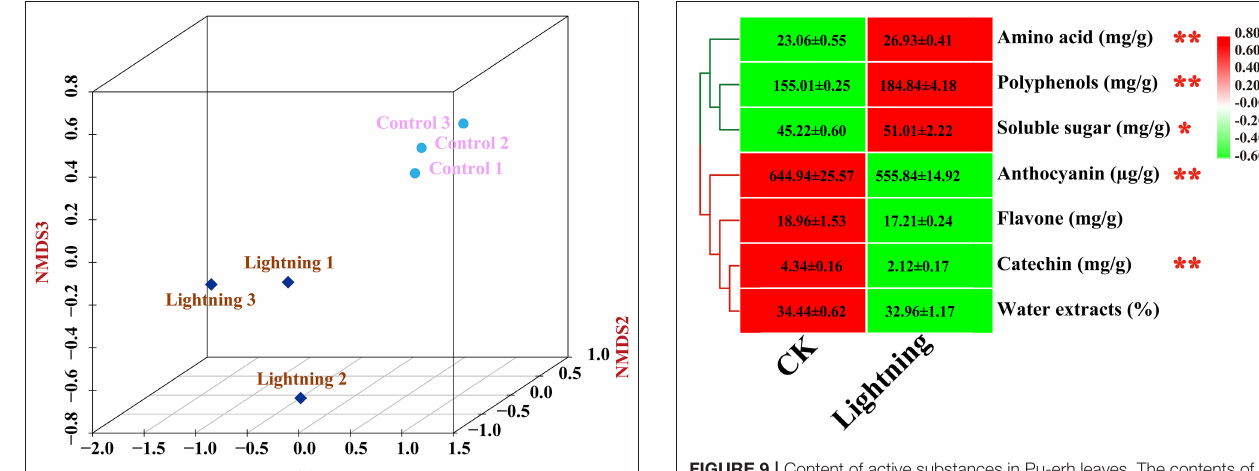
FIGURE 9 | Content of active substances in Pu-erh leaves. The contents of different elements are expressed as mean values ± standard deviation (SD) (mg/kg). Lighting represents a sample 10m from the lightning rod; CK indicates that the distance between the sample and the lightning rod is > 500m. *Indicates significant differences between different samples at the level of P < 0.05, while ** indicates significant differences between different samples at the level of P <